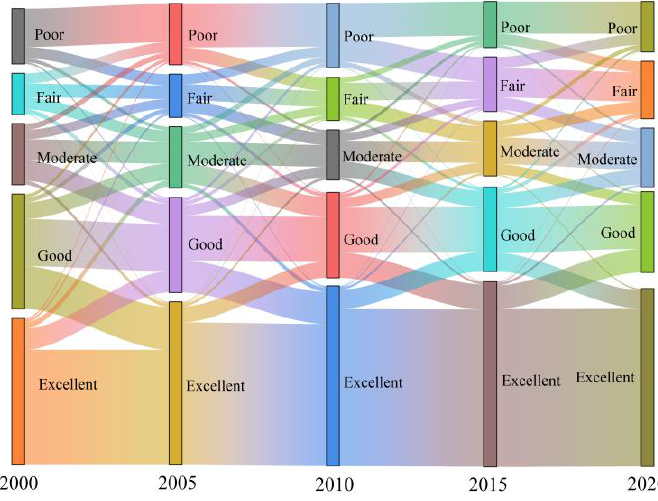
Figure 4. RSEI transfer matrix for Fuzhou City, 2000 – 2020.